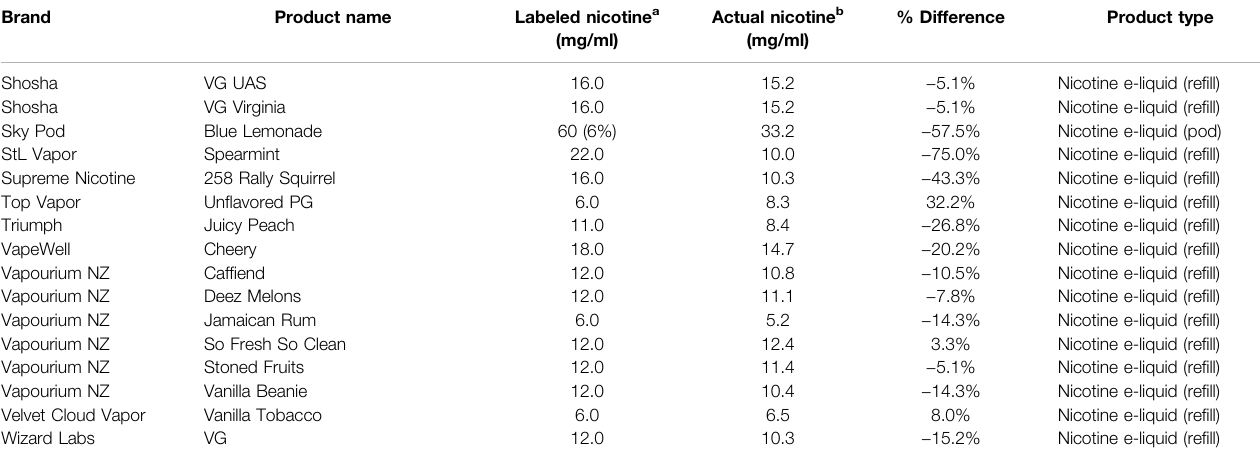
Frontiers in Chemistry |